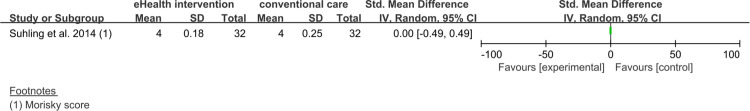
Forest plot without a pooled estimate demonstrating the effectiveness of an eHealth intervention for medication adherence in organ transplant patients.The one study presented here used subjective methods to measure medication adherence in organ transplant patients and presented the results as continuous data.